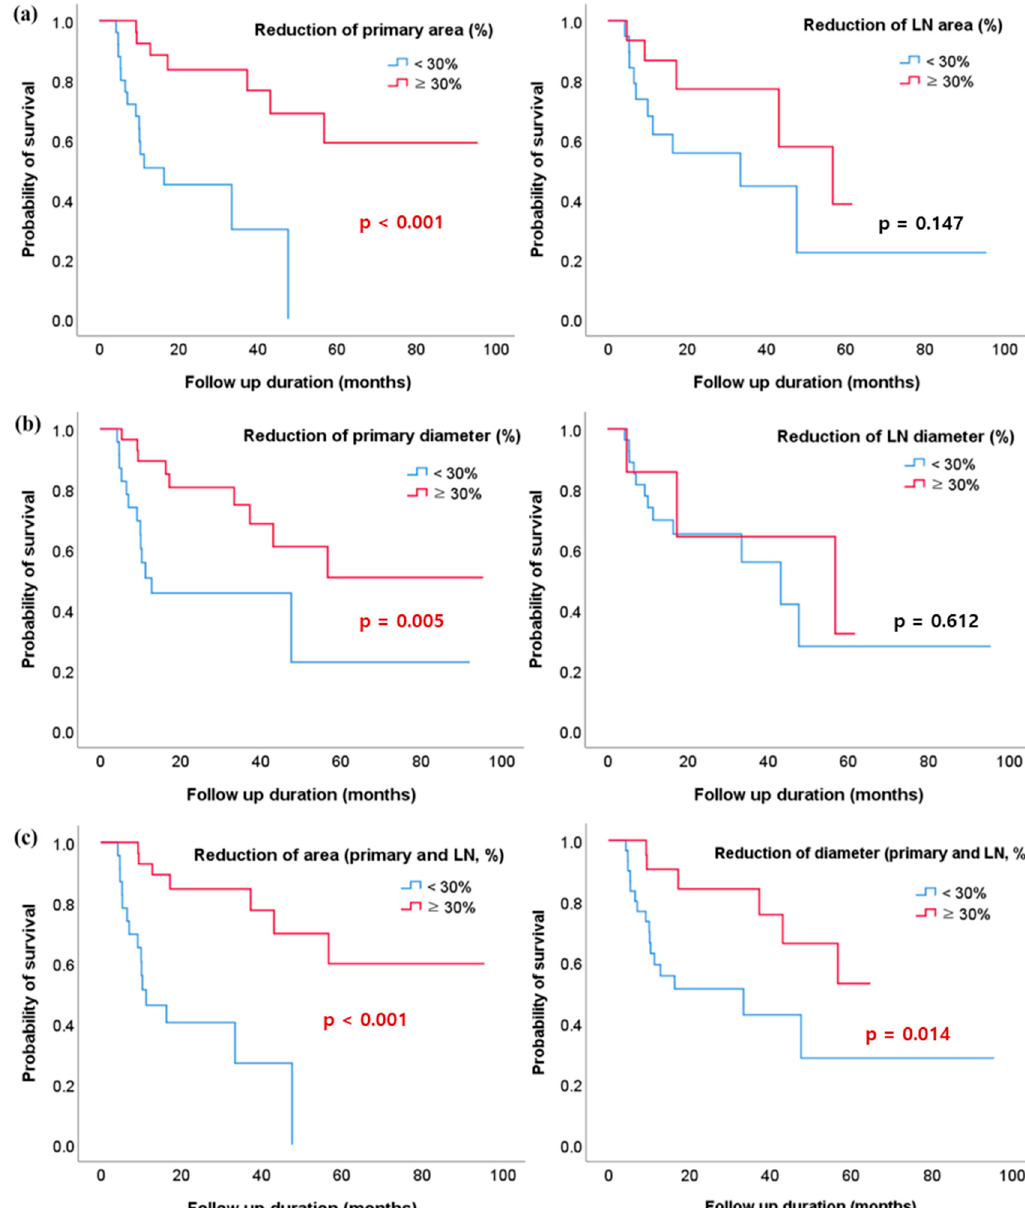
Figure 4. Kaplan–Meier analysis of overall survival (OS) rates shows a relationship between the reduction of lesion size and OS ( a ) Area reduction of the primary esophageal lesion/lymph node (LN) and OS rates; ( b ) Diameter reduction of the primary esophageal lesion/LN and OS rates; ( c ) Area and diameter reduction of both lesions (sum of primary esophageal lesion and LN) and OS rates.